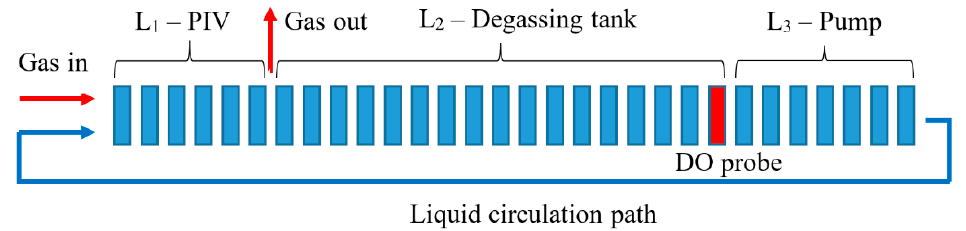
Figure 6. Illustration of the plug flow model used to simulate gas–liquid mass transfer in the CLR.